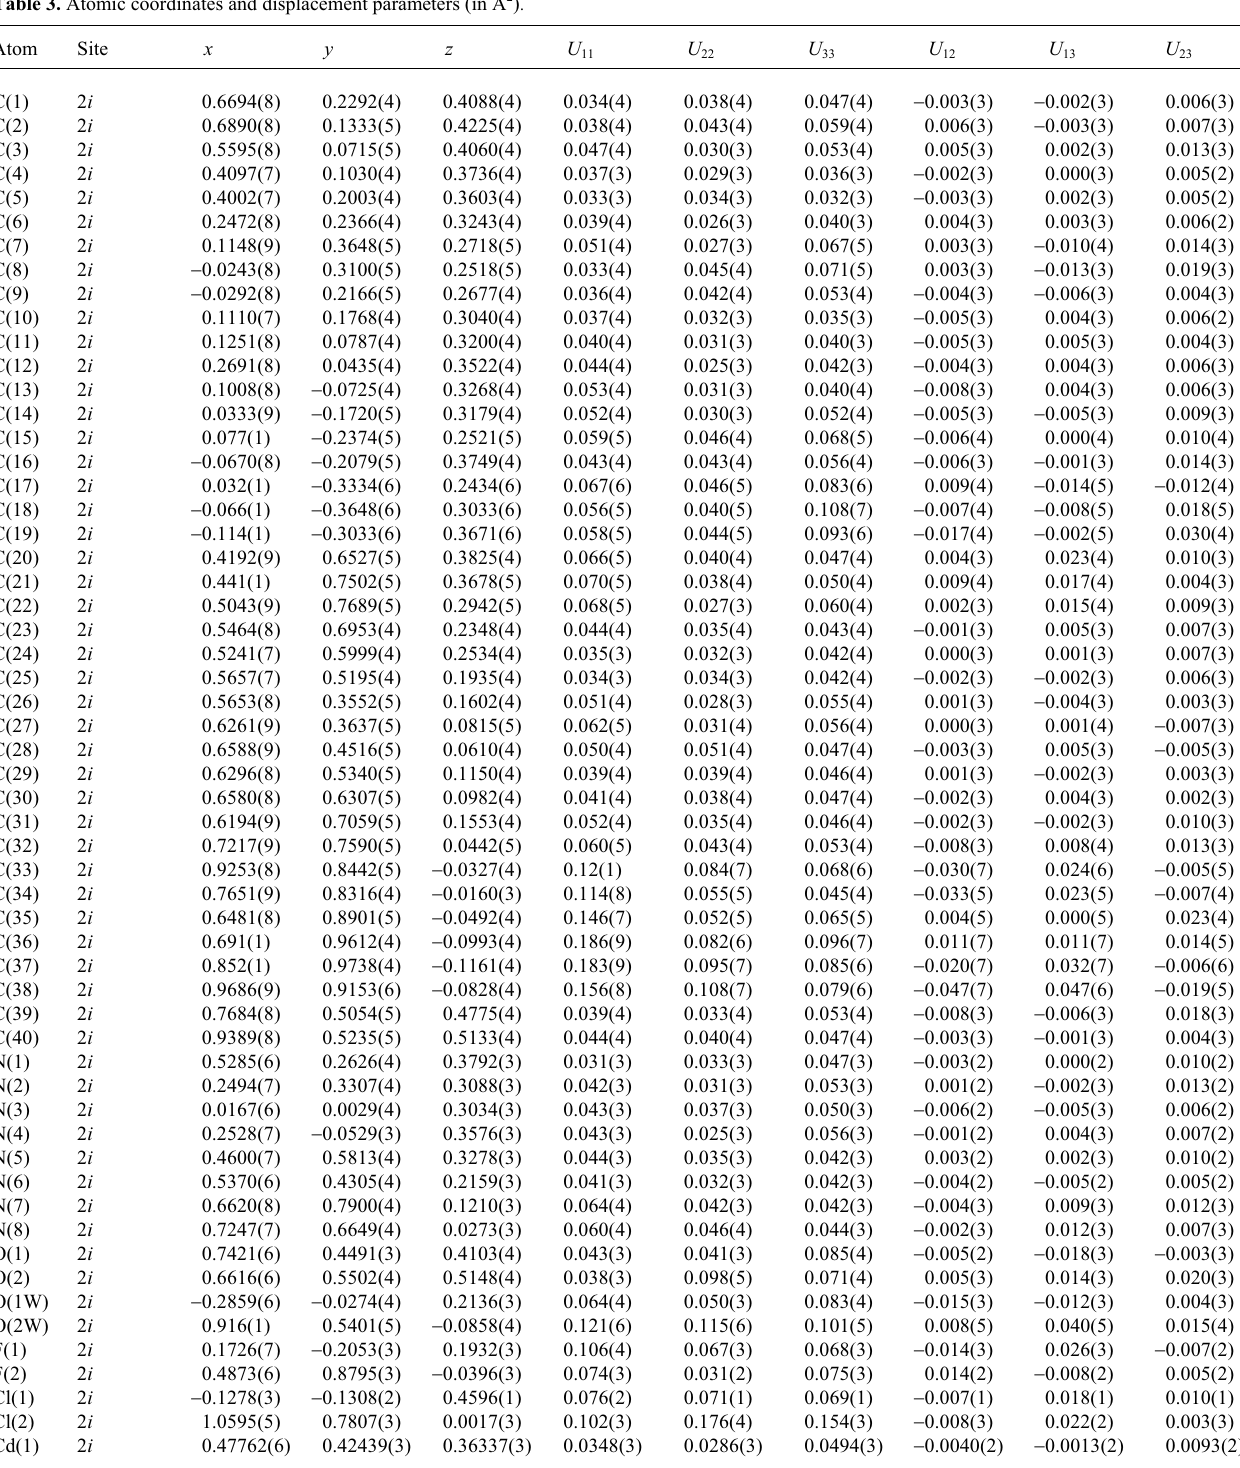
Table 3. Atomic coordinates and displacement parameters (in Å 2 )